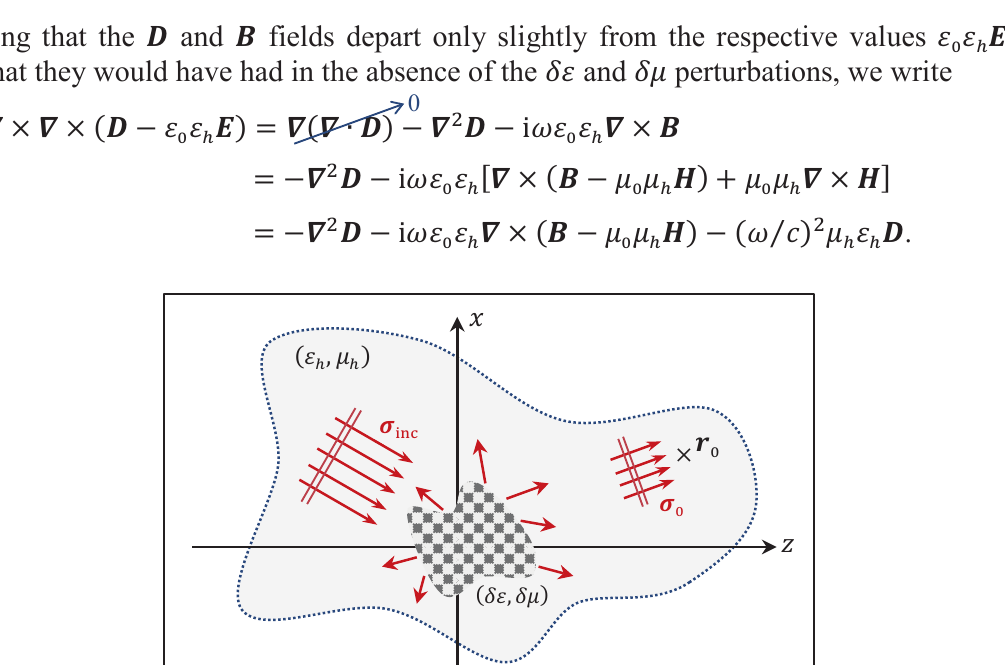
Fig.9 . A monochromatic plane-wave of frequency (cid:2033) and (cid:1831) -field amplitude (cid:2161) within a mildly inhomogeneous host medium of refractive index (cid:1866) the unit-vector (cid:2252) (cid:3167)(cid:3172)(cid:3161) ) ½ . The inhomogeneous region of the host, a small patch in the vicinity of the origin of ( (cid:2020) (cid:2013) (cid:3283) (cid:3283) coordinates, is specified by its relative permittivity (cid:2013)